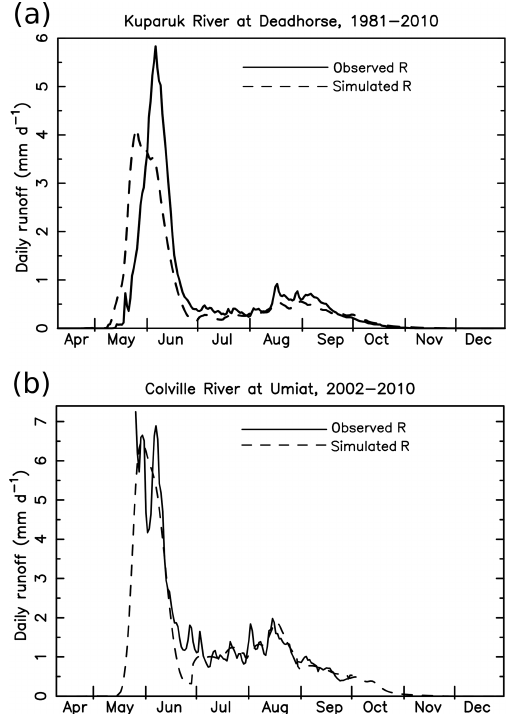
Figure 3. Simulated and observed runoff ( R , mmd − 1 ) for the (a) Colville River at Umiat, AK and (b) Kuparuk River at Dead- horse AK. Data for the Colville River (USGS Colville River, 2019) is available from May until early October since 2002. Runoff cal- culated as unit depth as in Fig. 2. Methodology used for deriving simulated composite R for the Colville is described in Sect.